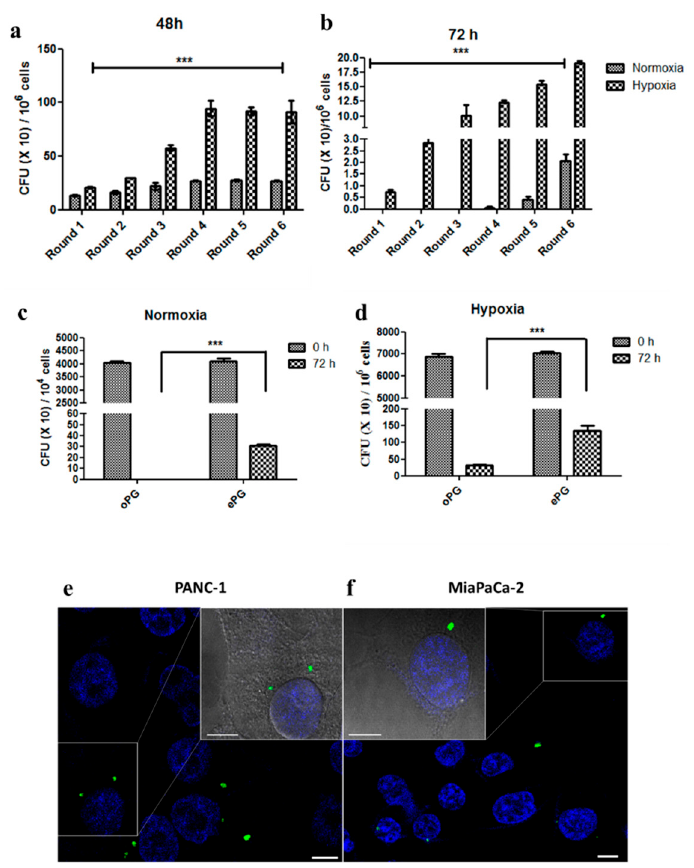
Figure 3. P. gingivalis intracellular survival in PDAC cells can be enhanced in vitro. ( a , b ) Intracellular P. gingivalis CFU recovered 48 h and 72 h after infection. ( c , d ) Intracellular “original” vs. “enhanced” P. gingivalis (see text for explanation) recovered immediately after antibiotic treatment (0 h) or after 72 h in normoxic or hypoxic conditions. Experiment was performed three times. Data show the mean ± SD of a representative experiment ( n = 2 wells per condition). Two-way ANOVA was performed for statistical analysis. *** p ≤ 0.005. ( e , f ) FITC-labeled P. gingivalis was used to infect PANC1 or Mia Paca-2 cells. After 24 h infection, cells were fixed and nuclei were stained with DAPI prior to visualization using a NIKON confocal microscope at 60 × magnification. One cell is magnified and shown with brightfield overlay for each image. The experiment was performed